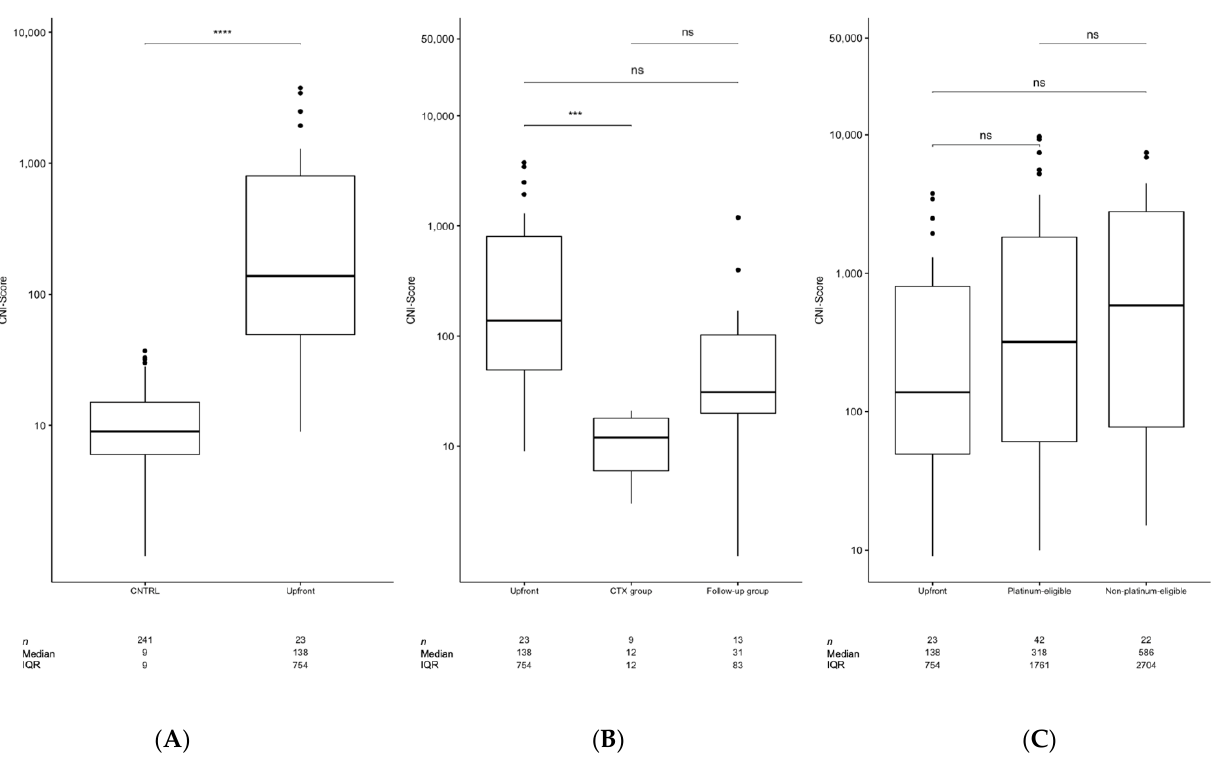
Figure 1. ( A ) Comparison of the CNI-Scores obtained from apparently healthy controls and the respective patient groups. ( B ) Comparison between the upfront group and the CTX group. ( C ) CNI-Scores from the upfront, the platinum-eligible, and platinum-non-eligible recurrence groups of patients. The centerlines show the medians; box limits indicate the 25th and 75th percentiles, as determined using a non-parametric Wilcoxon test (R); whiskers extend 1.5 times the interquartile range from the 25th and 75th percentiles; and outliers are represented by dots. The number of sample points per group (n), median, and interquartile range (IQR) are given as tables. A non-parametric Wilcoxon test was performed to test for statistical differences between the groups (ns: p > 0.05, ***: p ≤ 0.0 01, ****: p ≤ 0.0001) and adjusted for multiple testing.